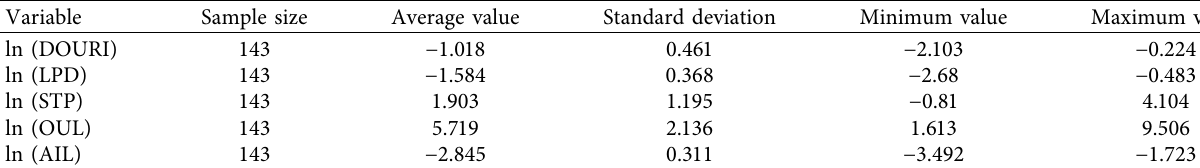
Table 3: Descriptive statistics of observation samples.